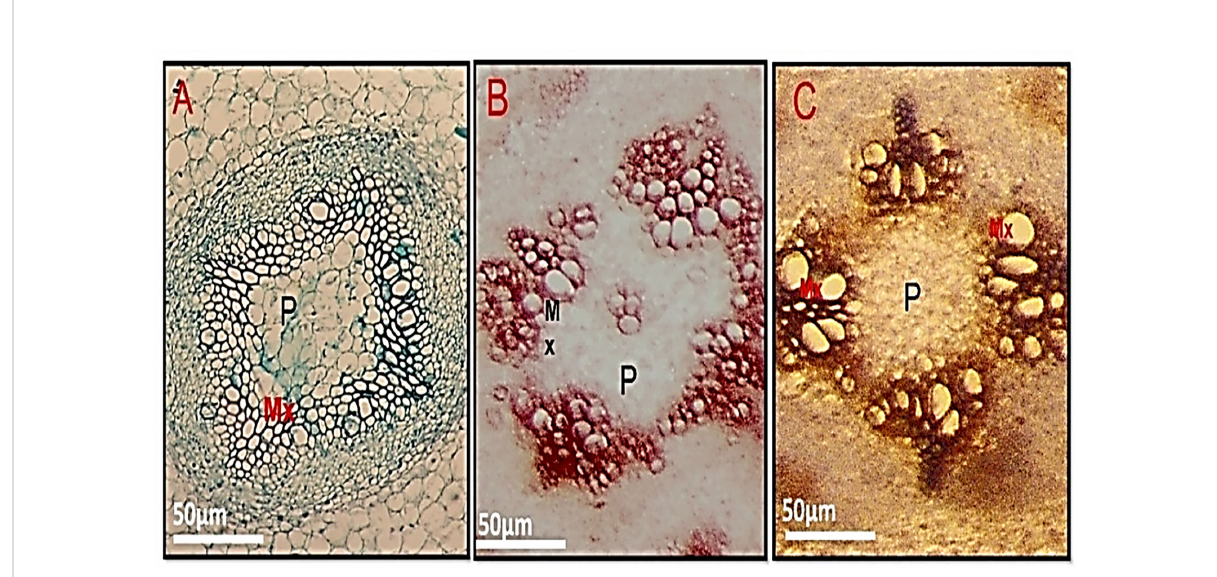
(Figure 6B), compared to control plant roots (Figures 6A). Lignin detection in the endodermis and parenchymatous pith.